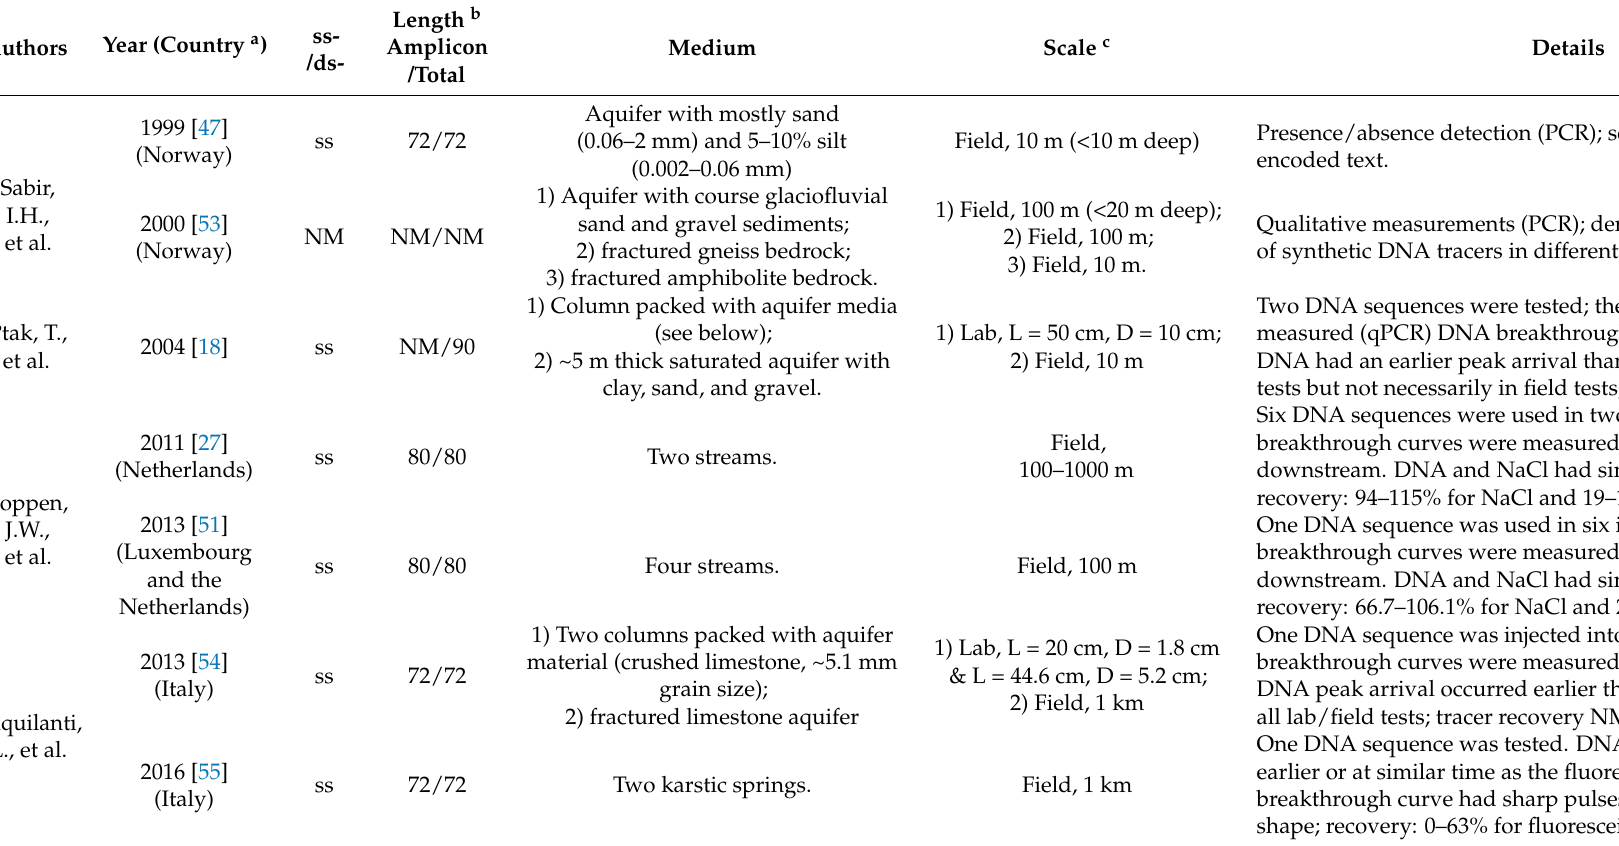
Table 1. Summary of the literature on the use of naked synthetic DNA molecules as hydrological/reservoir tracers. Studies are grouped according to the first author and are presented in chronological